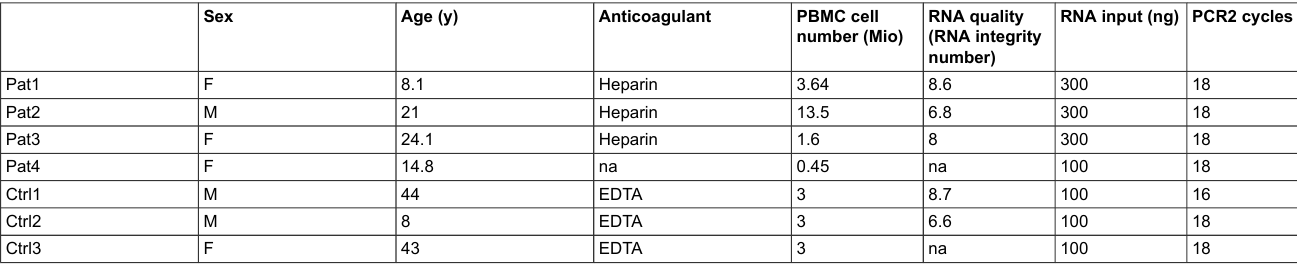
Table 1: Patient characteristics, sample handling and library preparation specificities. Sex Age